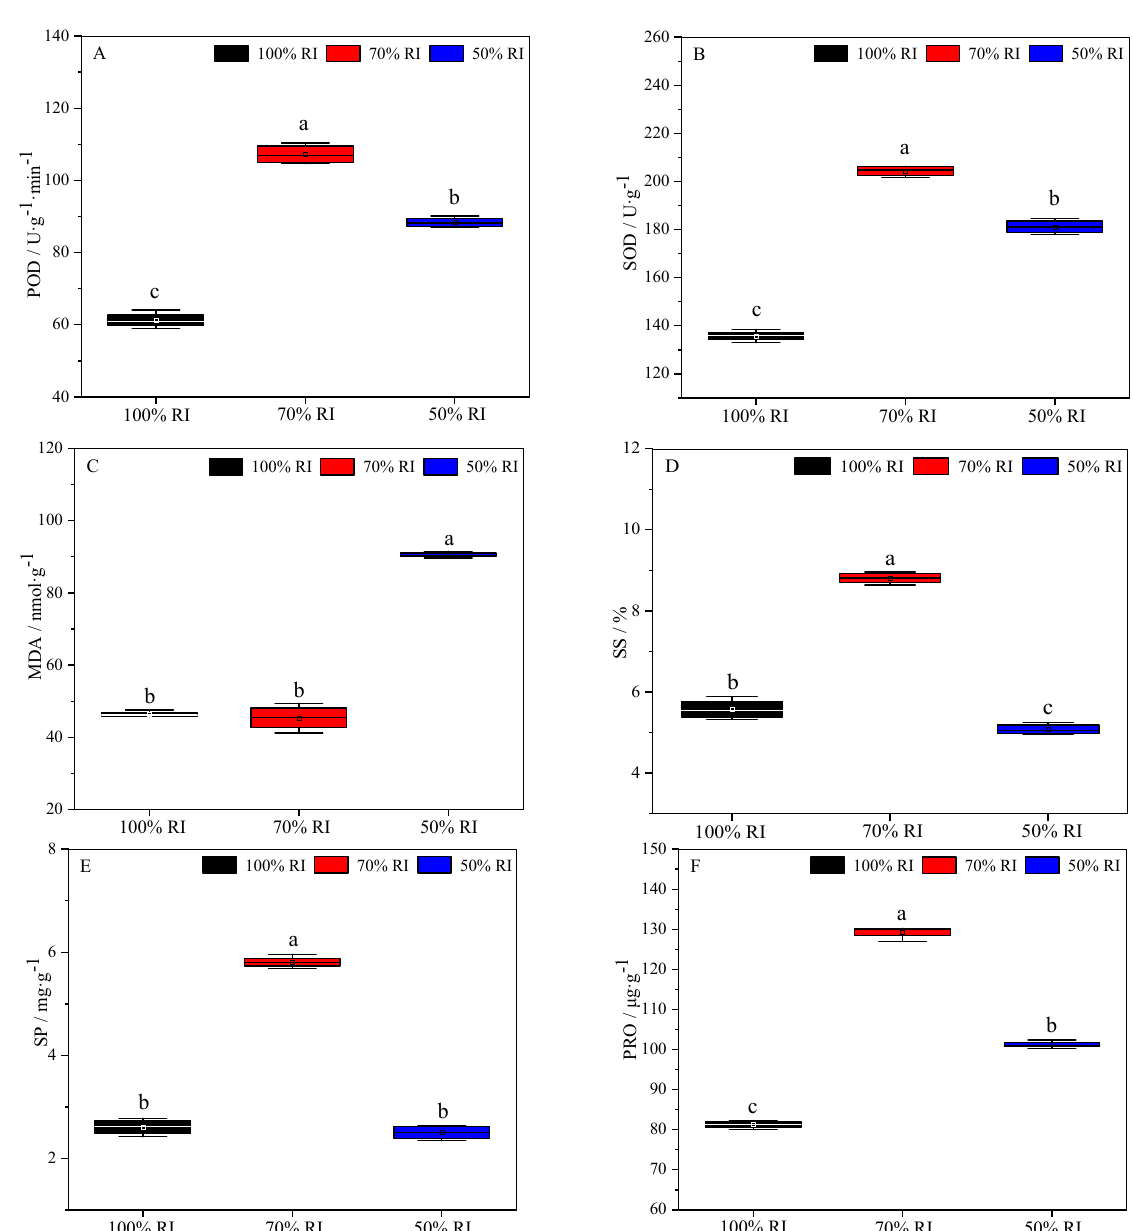
10 of 17 Figure 3. Comparison of chlorophyll fluorescence parameters of P. massoniana seedlings under different light treatments (means ± SDs), n = 6. The letters denote: ( A ) the slow induction kinetics parameters of dark-adapted leaves; ( B ) relative electron transfer rate of PSII at 0-1500 µmol·m − 2 ·s − 1 . Abbreviations: RI, relative irradiance; Fv/Fm, maximum photochemical efficiency; Y(II), actual quantum yield; q p , photochemical quenching; NPQ, non-photochemical quenching; ETR, relative electron transfer rate. Significant differences are indicated: p < 0.05. 3.6. Physiological and Biochemical Properties at Different Light Intensities The POD and SOD activity in P. massoniana seedling needles first increased and then decreased with decreasing light intensity from 100% RI to 50% RI (Figures 4A, B). POD